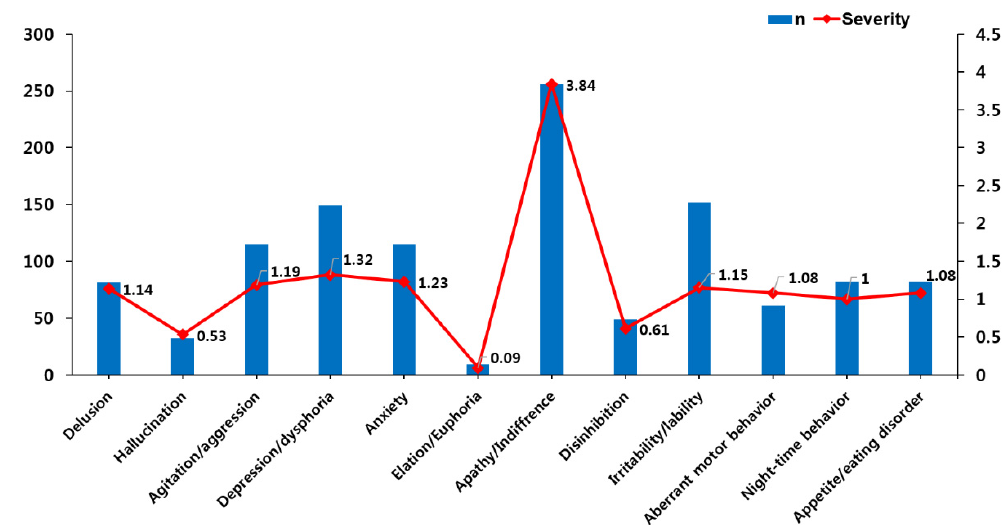
Figure 1. Prevalence and severity of behavioral and psychological symptoms at the first time of dementia diagnosis.